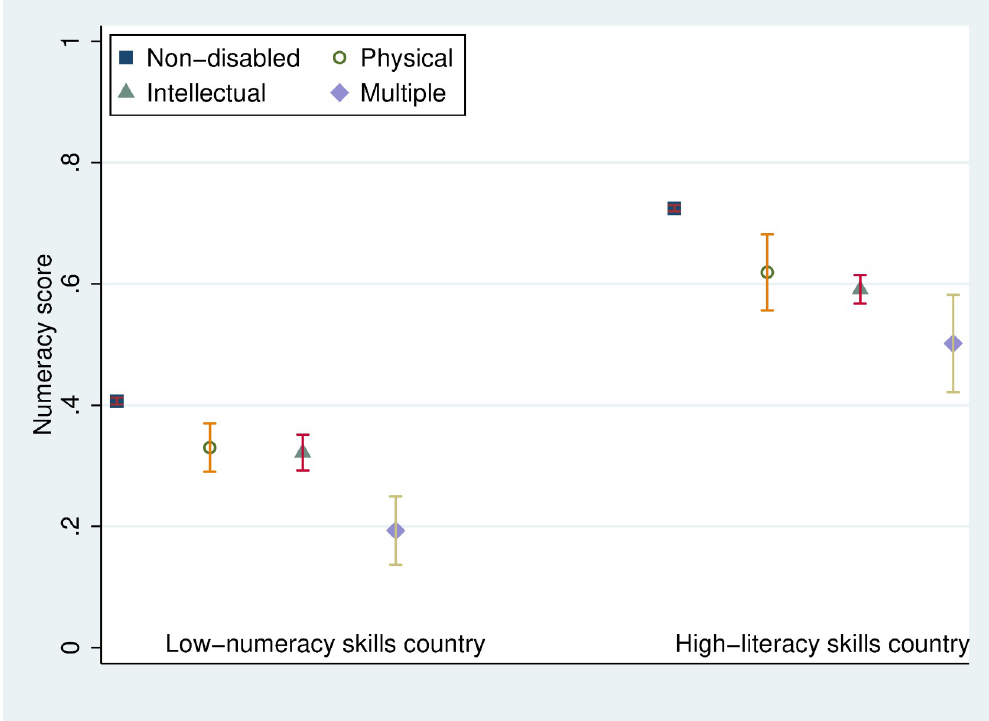
Fig 4. Mean numeracy test scores with 95% confidence intervals for the means in low- and high-numeracy skills countries.